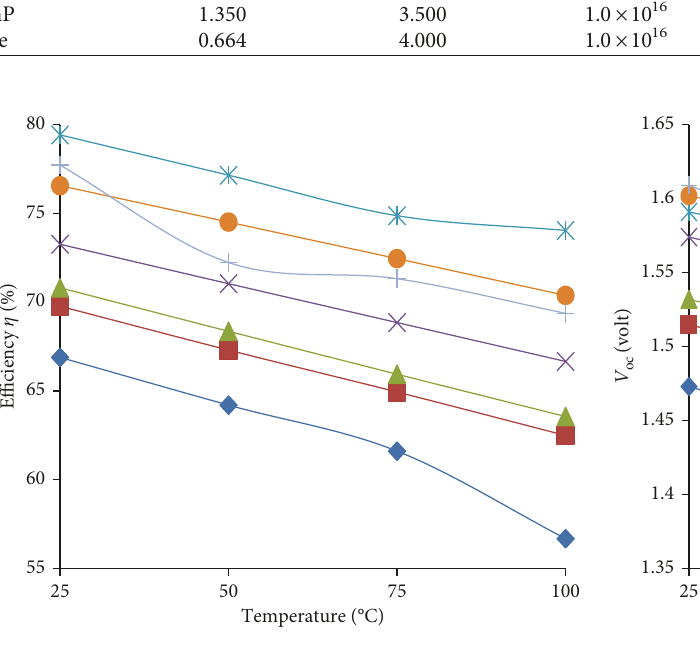
Figure 1: The incoming AM1.5d spectrum and the range of absorption of each subcell for (a) SIMF Table 1: The input parameters for the standard simulation (at one sun spectral irradiance and the temperature of 25 ° C). Subcell Al 0.3 Ga 0.7